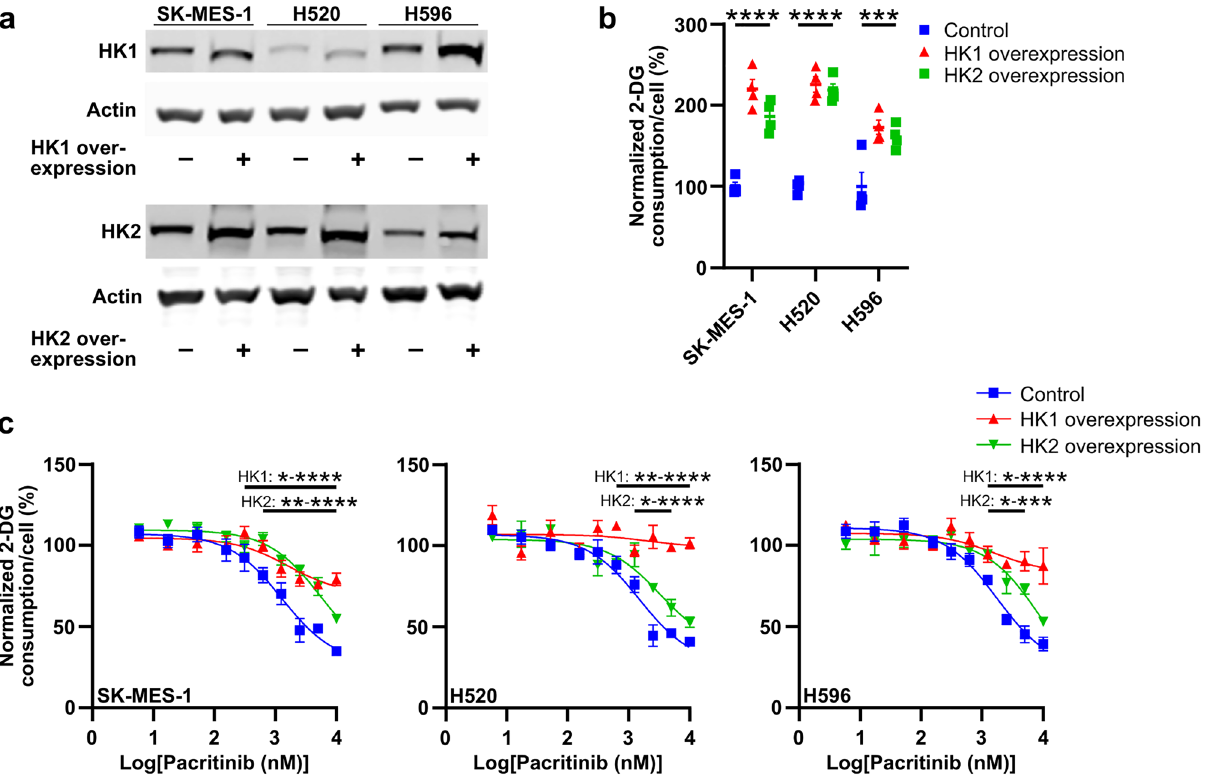
Figure 4. Hexokinase 1 overexpression rescues the inhibitory effect of pacritinib on glucose consumption. ( a ) Representative immunoblots of Hexokinase 1 (HK1) and Hexokinase 2 (HK2) protein levels in SK-MES-1, H520, and H596 cells transfected with HK1 and HK2 overexpression plasmids, respectively, or a control plasmid. Full-length, uncropped blots are presented in Supplementary Figure. 3. ( b ) Glucose consumption in control, HK1 overexpression, and HK2 overexpression SK-MES-1, H520, and H596 cells. ( c ) Glucose consumption in control, HK1 overexpression, and HK2 overexpression SK-MES-1, H520, and H596 cells